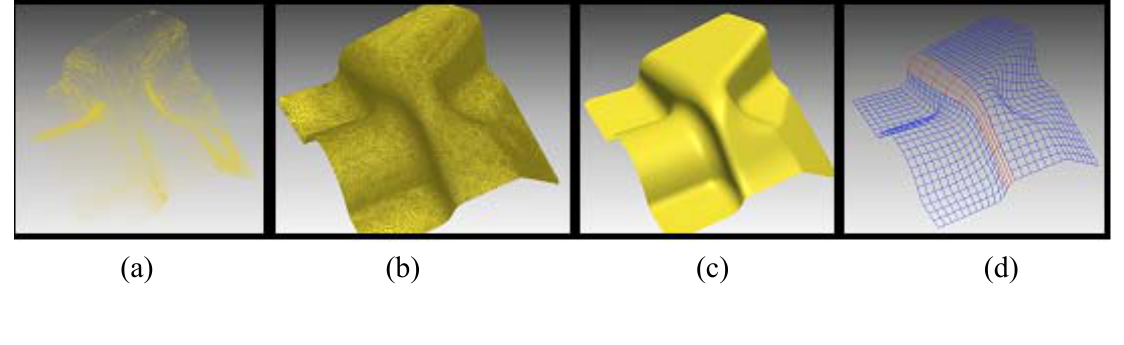
Figure 6. Surface modeling procedure from scanned data: a) Point cloud, b) polygon meshes, c) mesh treatment, d) surface